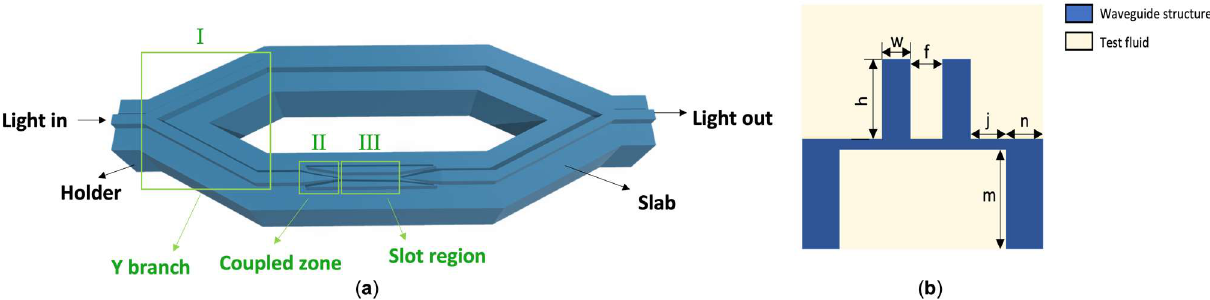
Figure 1. ( a ) Schematic of the liquid sensor based on the polymer suspended slot waveguide. ( b ) Cross-section of the sensor showing the holder on both sides of the waveguide and the slab beneath the device which forms the suspended structure. w, h, f, m, n, and j are the widths of waveguides on both sides of the slot, the slot height, the slot width, the holder height, the holder width, and the distance between the slot and the two holders, respectively.